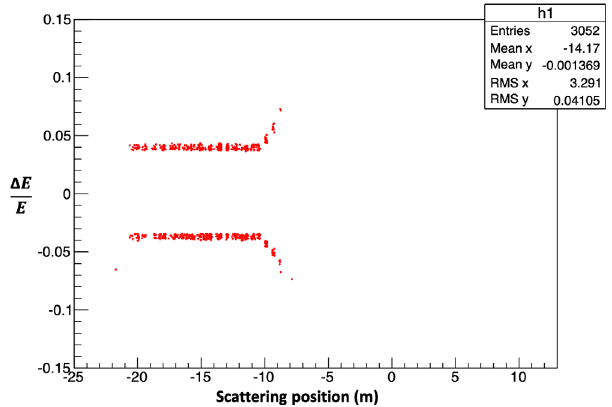
FIG. 7. The Δ E of the subset of Touschek positrons lost in the E drift where we placed our DS as a function of their scattering position (from